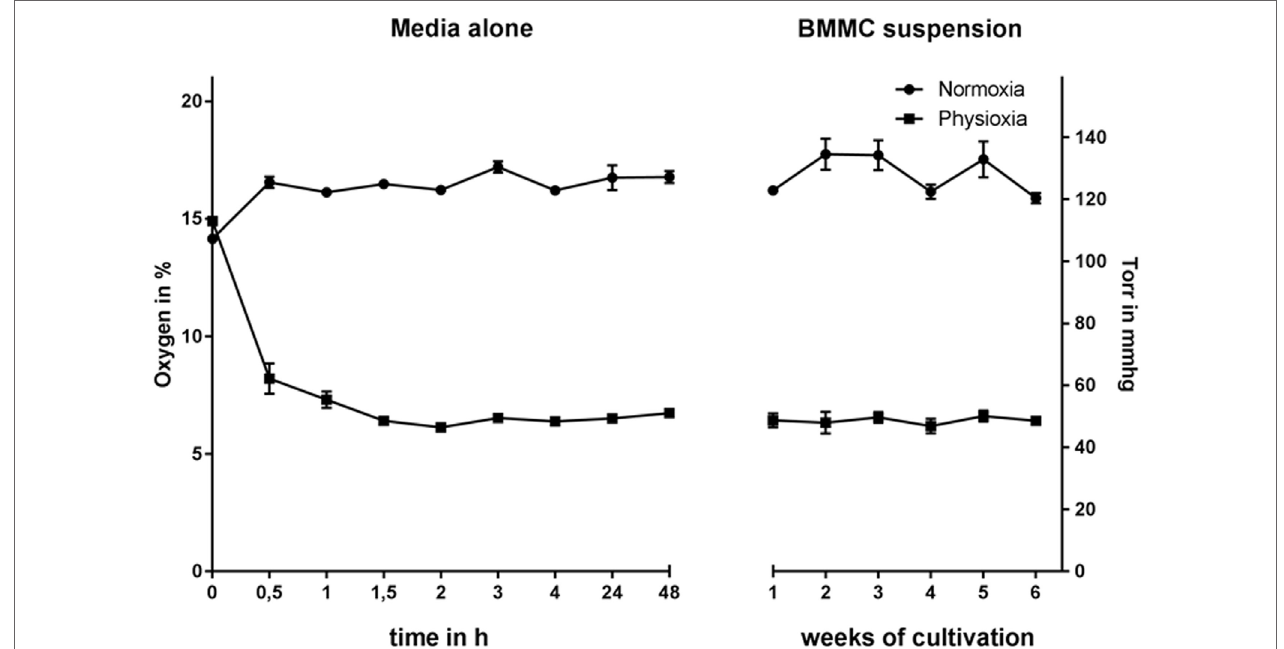
FiGUre 1 | Oxygen concentration in media without (left, monitored up to 48 h under physioxia) and in BMMC suspension culture (right, monitored every week) under normoxia and physioxia, measured using a Fibox4-PSt3 measurement system (PreSens ® ). The oxygen level of both media alone as well as in the cell suspension stabilizes at around 53 mmHg (7% O 2 ) und physioxia, while the normoxic remains above 120 mmHg (16% O 2 ). Equilibration of the media is reached after approx. 1.5 h. Depicted are the mean values and SDs of n = 4 experiments with cells derived from 4 mice (not